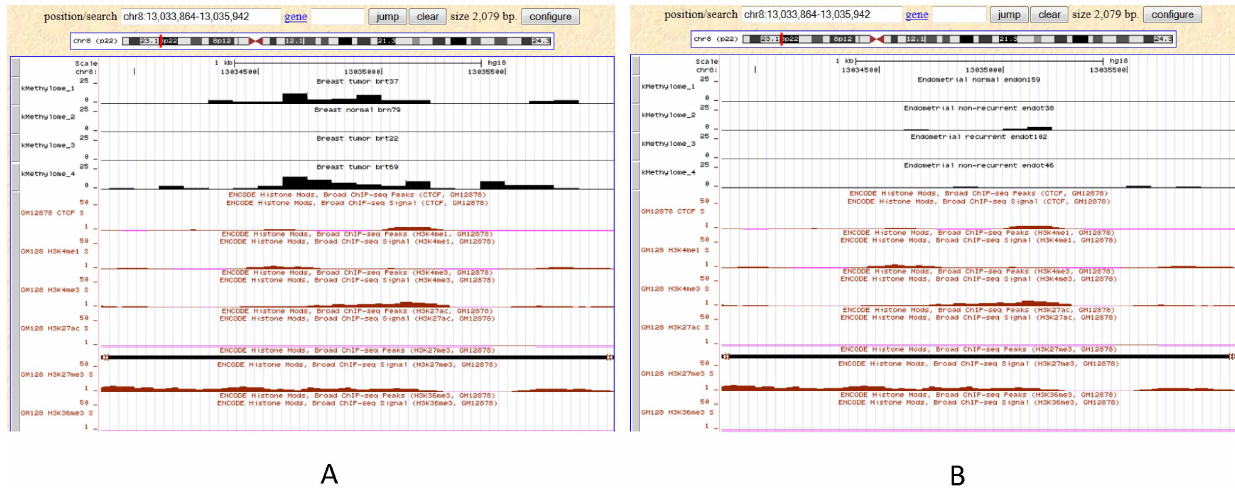
Figure 6. Visualization of DNA methylation and histone modification data. The TSS region of DLC1 is used as an example. 4 samples were randomly selected by marking the check box on the right side of the webpage for breast samples (e.g., brn80, brt22, brt69 and brt37). The ‘‘full’’ option for every custom track and the Broad Histone tracks was selected for the comparison of DNA methylation and histone modification marks. Similar results were obtained as previous report [4]. An exception (the 3 rd track, brt22) was found which shows patient specific patterns (A); and there was no increased methylation found for endometrial samples (B).